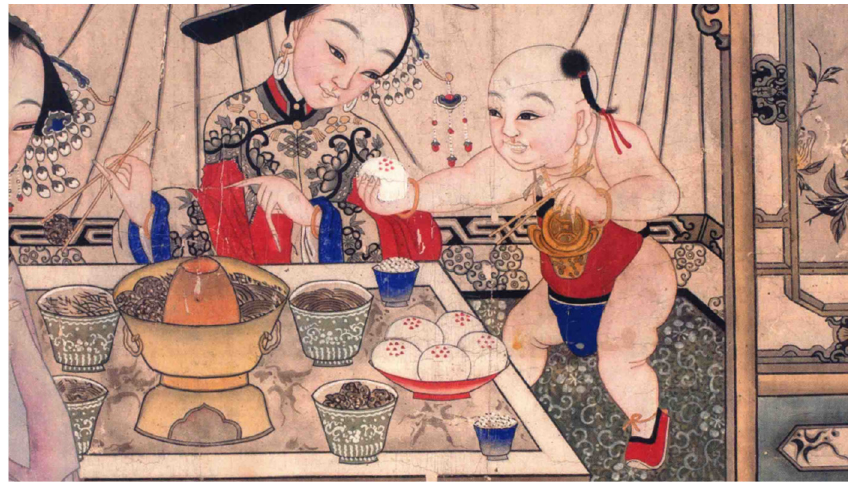
Figure 2. Partial Yangliuqing New Year prints.